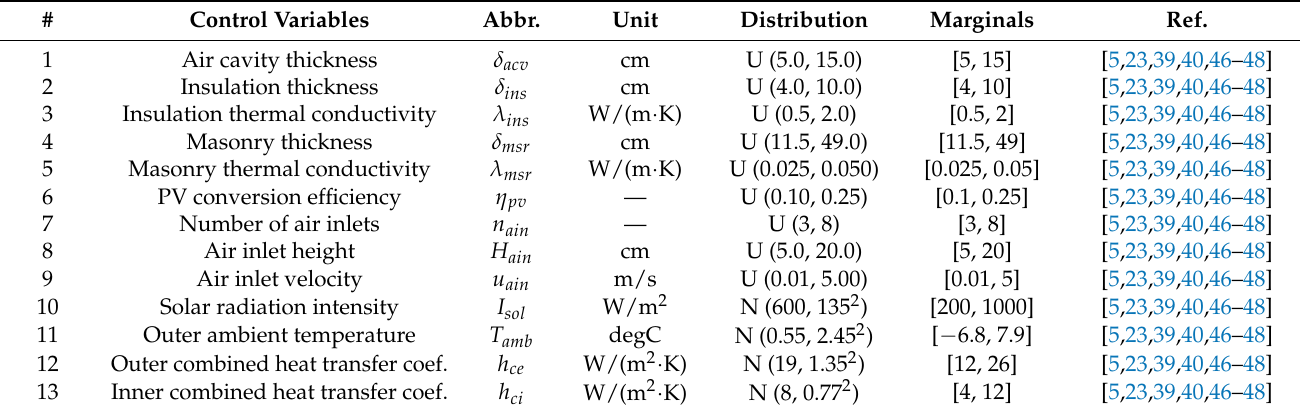
Table 1. Control variables considered in relation to the ambient, design and operation of the HAB- BIPV/T